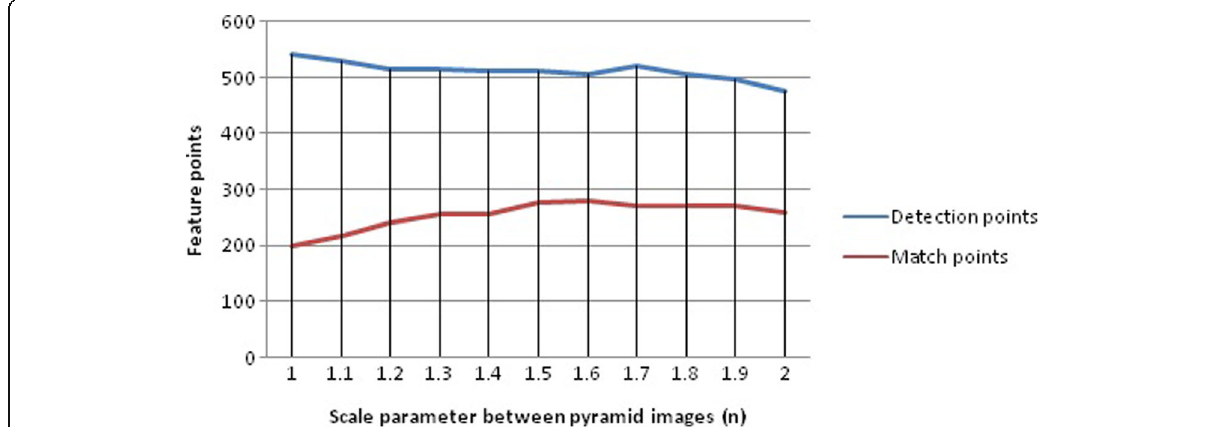
Fig. 7 Comparison of the number of feature points detected and the number of exact matches when the scale parameters of the pyramid image change